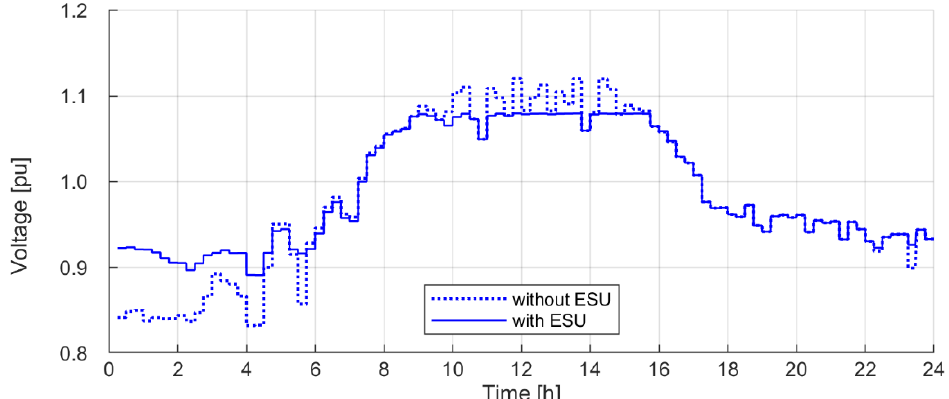
Figure 11. Daily voltage variations in node 526 (profile A).